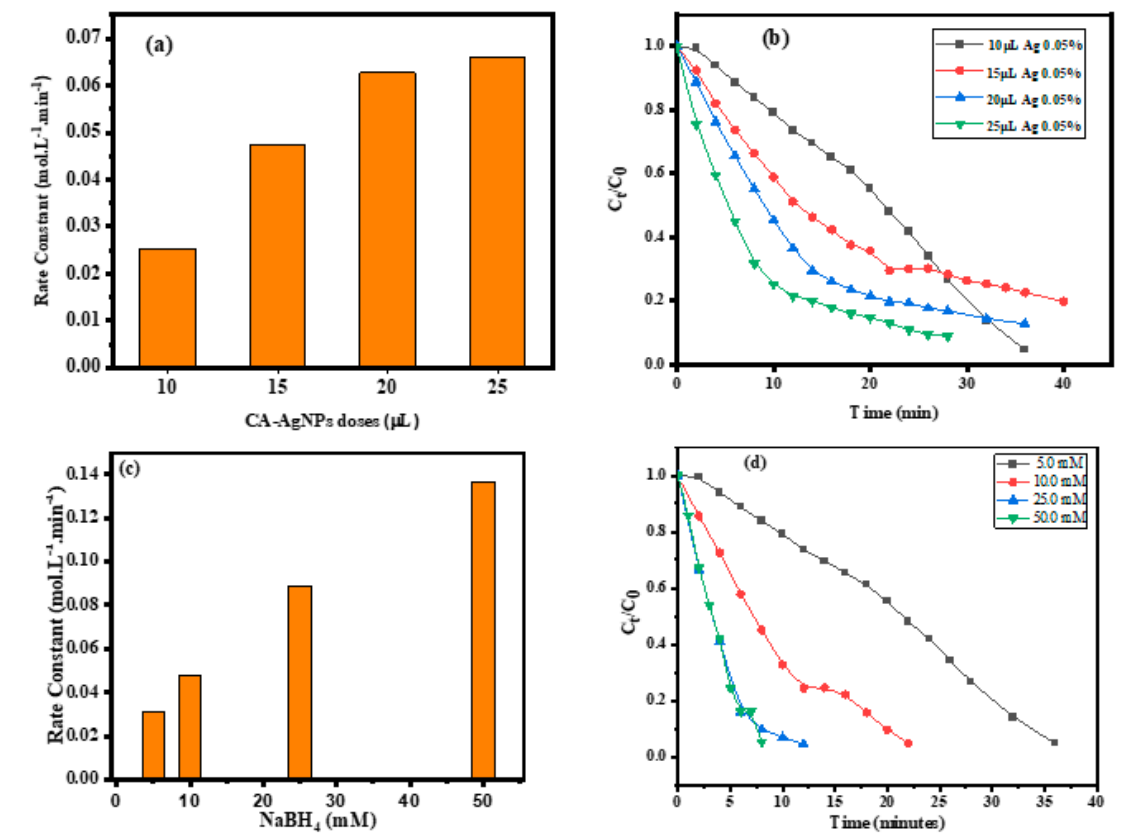
Figure 8. CR zero-order reaction rate constant and dye degradation after applications; ( a ) Different doses of 0.05% CA-AgNPs ( 15, 20, 25 and 30 μ L) at constant 5.0 mM NaBH 4 concentration; ( b ) C t /C o vis Time plots at different CA-AgNPs concentrations; ( c ) Different concentration of NaBH 4 (5, 10, 25 and 50 mM) at constant CA-AgNPs (20 μ L, 0.05%); ( d ) C t /C o vis Time plots at different NaBH 4 concentrations.